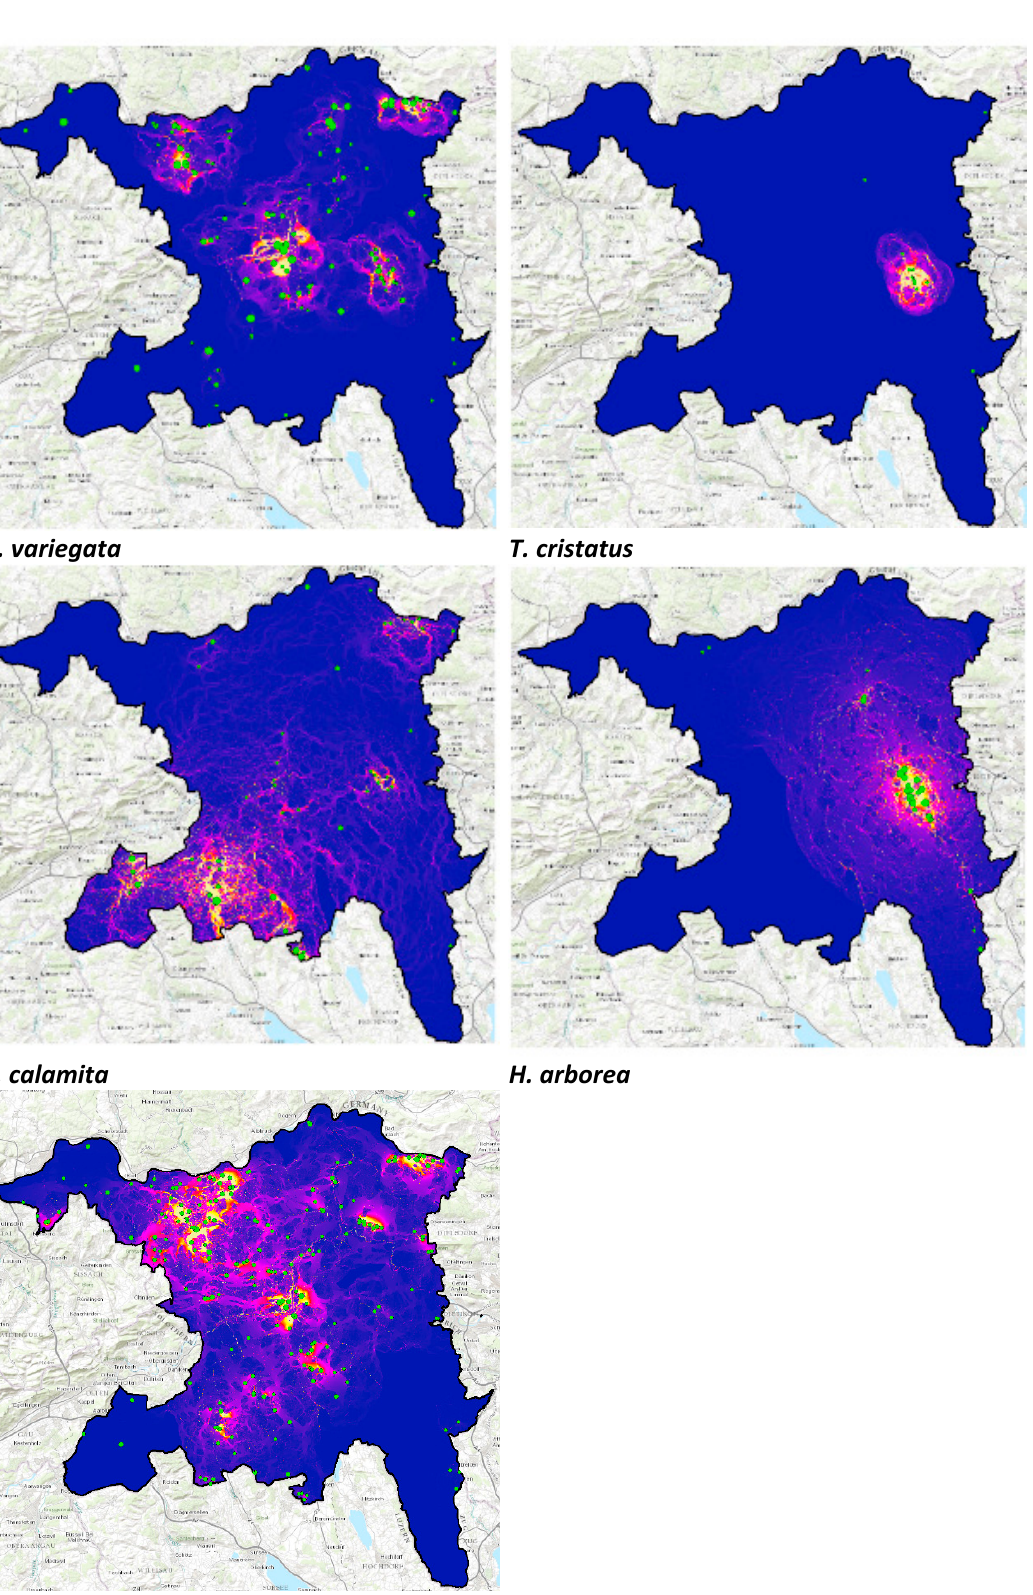
Figure A1. Functional connectivity maps for Bombina variegata, Triturus cristatus, Epidalea calamita, Hyla arborea , and Alytes obstetricans. The green circles indicate the locations of breeding